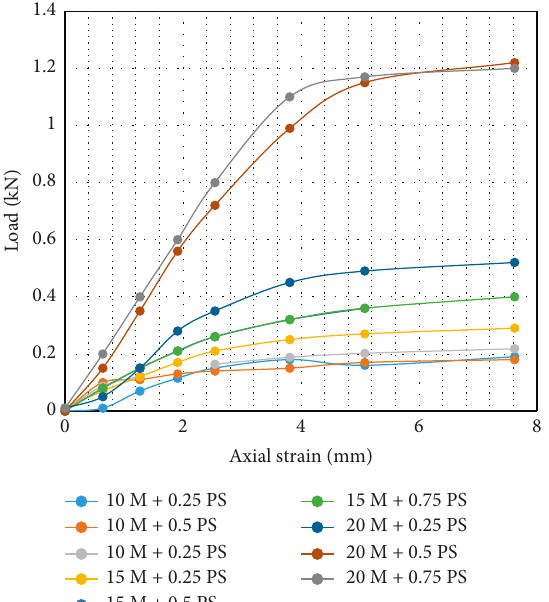
Figure 6: CBR graphs of improved soil at different percentages of marble dust and plastic strips.